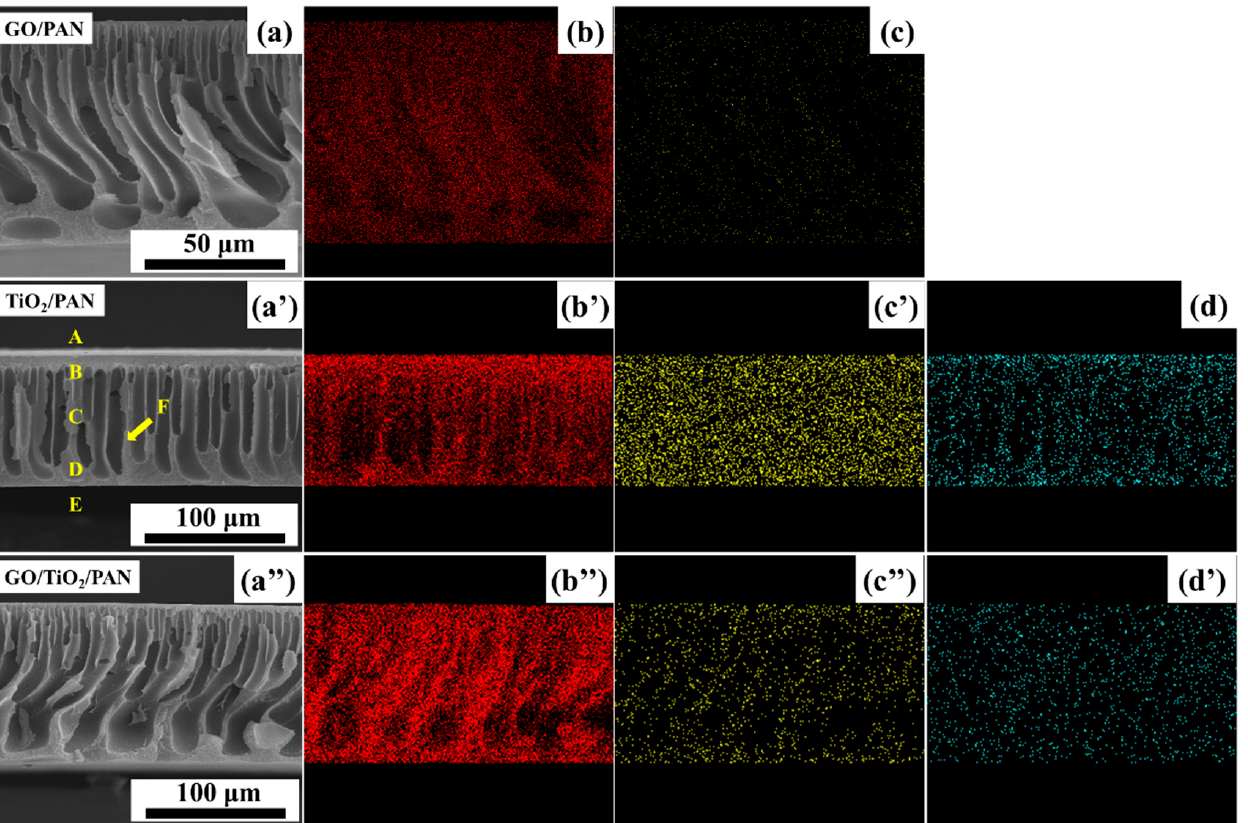
Figure 7. SEM images of the ( a ) GO/PAN, ( a` ) TiO 2 /PAN, and ( a`` ) GO/TiO 2 /PAN membranes’ cross-sections. ( b ), ( b` ), and ( b`` ) element C, ( c ), ( c` ), and ( c`` ) element O and ( d ), ( d` ) element Ti distribution (points measured by EDX mapping analysis) on the membranes’ cross-sections. A (top surface), B (upper wall of finger-like pore), C (middle wall of finger-like pore), D (lower wall of finger-like pore), E (bottom surface) and F (middle bulk body) were different regions in the same cross-section.